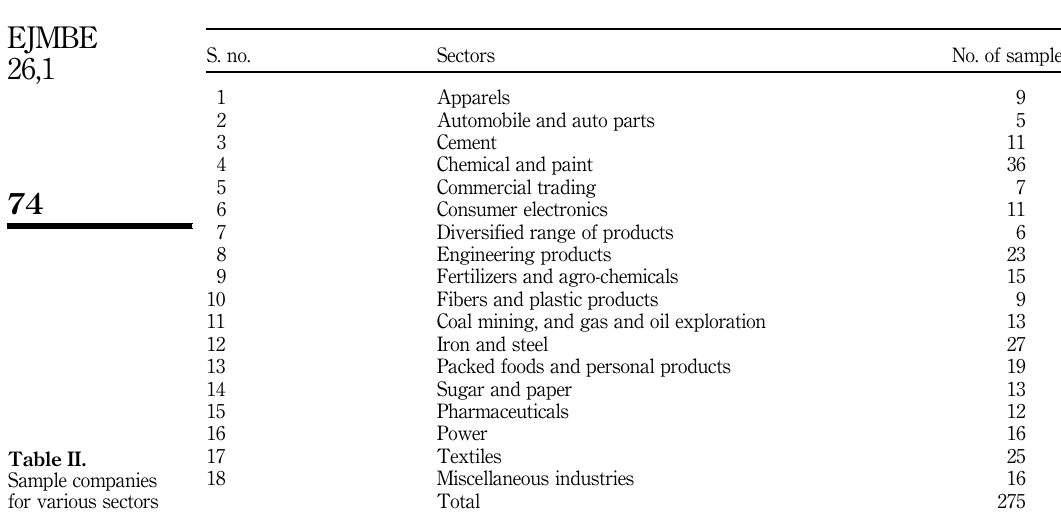
Table II. Sample companies for various